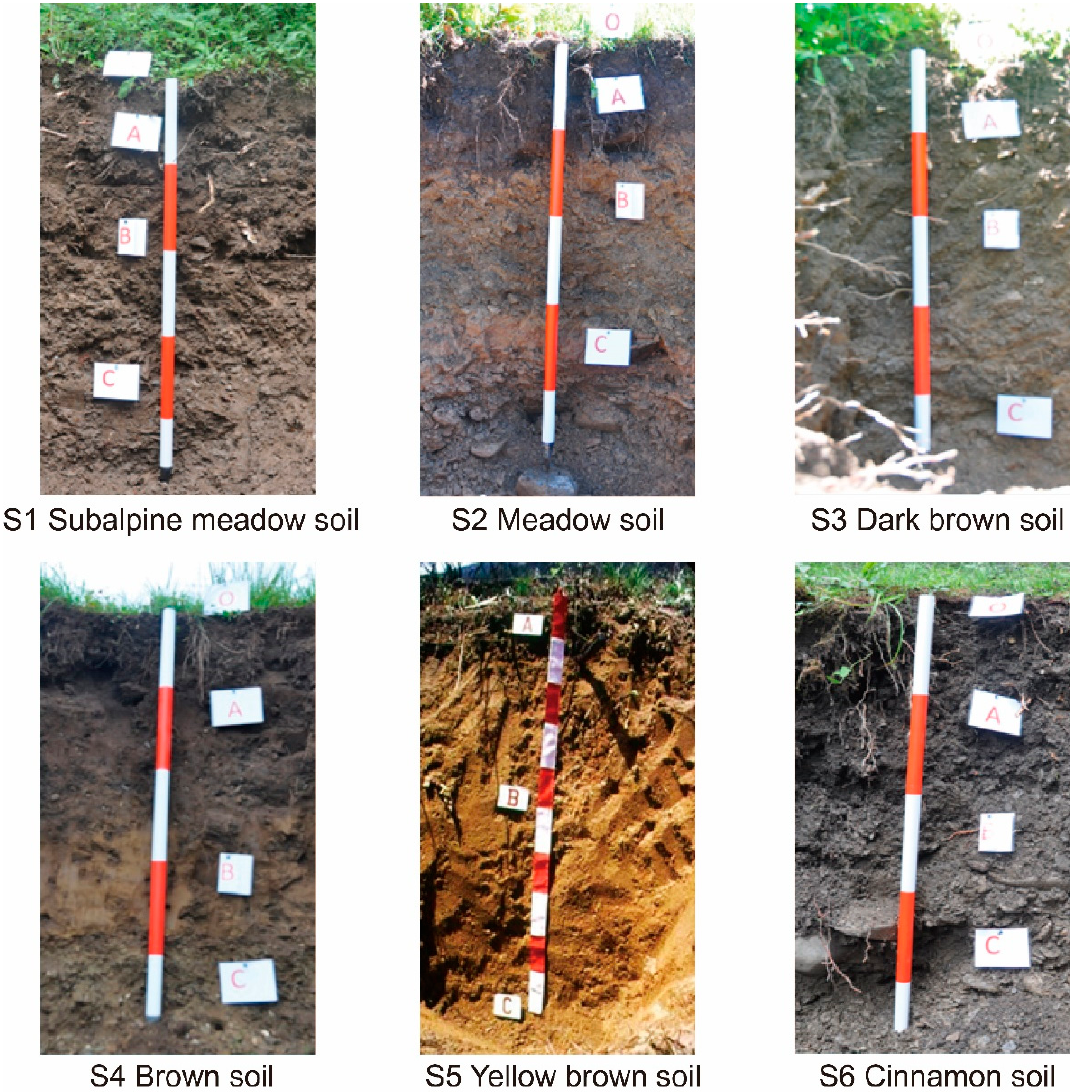
Figure 1. Profiles of main soil types (taken during sampling). O is humus horizon, A is leaching horizon, B is sediment horizon, and C is parent material horizon in the pictures. The picture of S5 (Yellow brown soil) was collected from Chine Soil